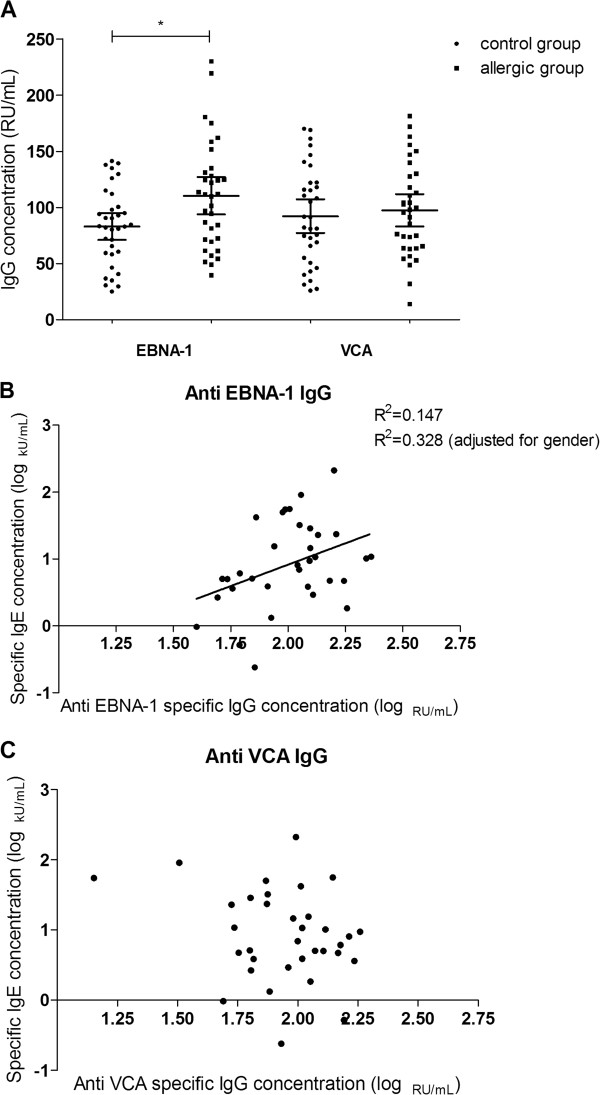
Anti EBNA-1 and anti VCA IgG concentrations in food allergic and control group. (A) Median and interquartile range (error bars) of EBV EBNA-1 and VCA IgG concentrations in 34 food allergic patients and 34 healthy controls. * p < 0.05, by t-test; (B) the linear regression between egg-specific IgE and anti EBNA-1 IgG (p < 0.05; p < 0.01, (adjusted for gender), by multiple linear regression); and (C) the linear regression between egg-specific IgE and anti VCA IgG (p > 0.05). R2 values are indicated.